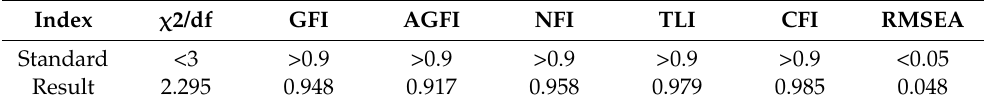
Table 2. Fit index values for the